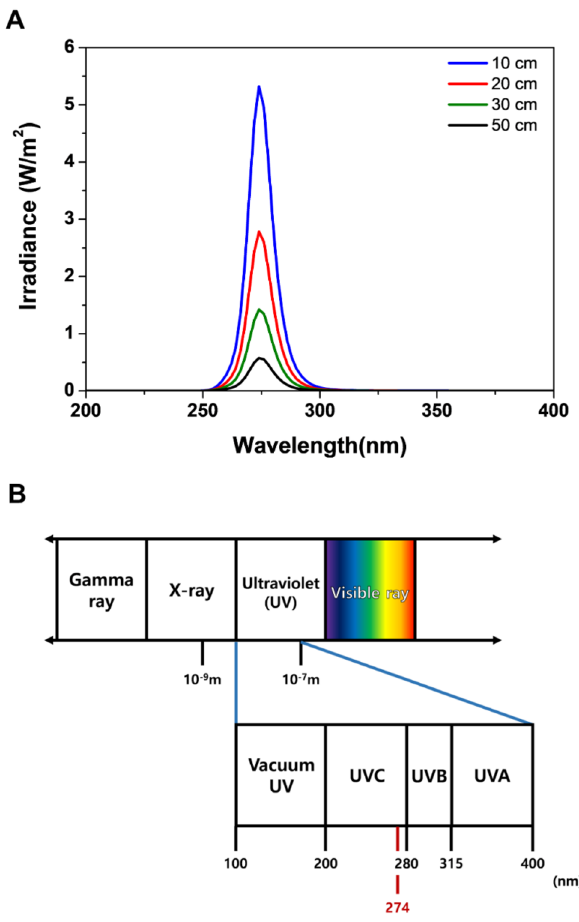
Figure 1. UV-LED irradiance as a function of wavelength. UV light corresponds to the area of light with wavelengths between 100 and 400 nm; a wavelength of 275 nm showed the highest measured irradiance in our